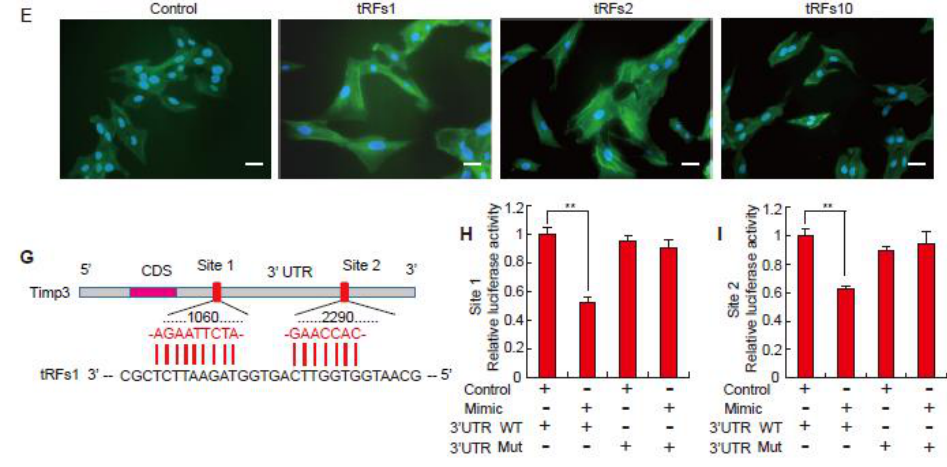
Figure 2. tRFs promote cardiac hypertrophy in cultured cardiomyocytes. ( A ) The distribution of different lengths of tRFs derived from tRNA-Gly-CCC; ( B ) Verification of the expression of tRFs by qRT-PCR, n = 3; ( C ) Transfection efficiency of tRFs mimics in the H9c2 cells, n = 3; ( D ) Relative mRNA expression of ANP , BNP, and β -MHC in treated H9c2 cells, n = 3; ( E ) Immunofluorescence evaluation of cardiac hypertrophy in cells treated with tRFs mimics. Bar indicates 50 µ m, n = 3; ( F ) The relative cell surface area in treated H9c2 cells, n = 3; ( G ) Sequence alignment of tRFs1 with 3 (cid:48) -UTR of Timp3;